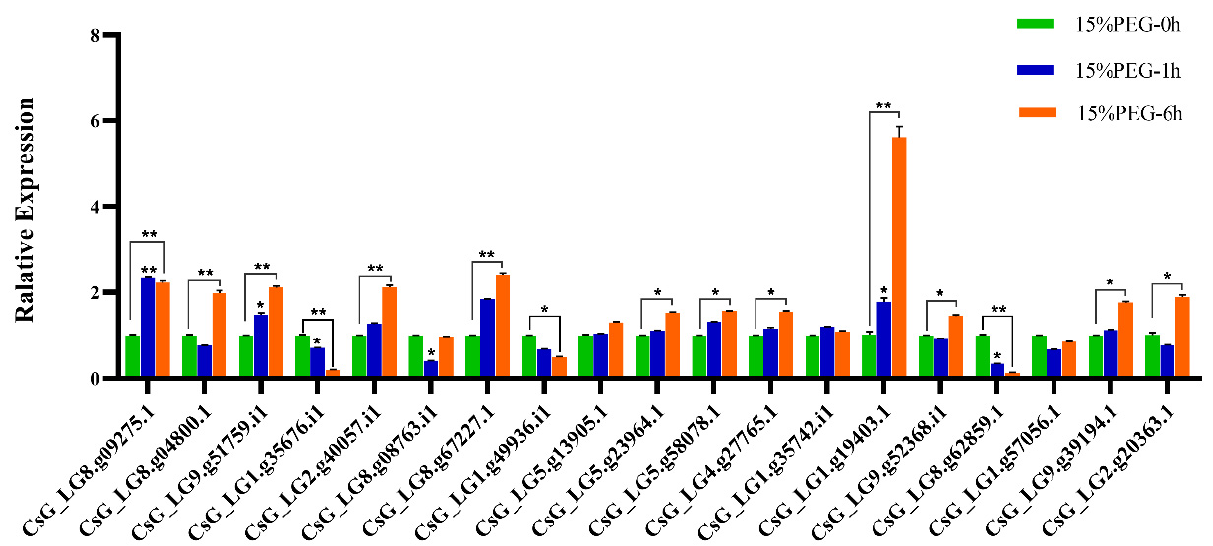
Figure 6. Expression patterns of CsNF-Y family genes in response to drought stress. The treatment concentrations were 15% PEG 6000. Values are mean ± S.D. * p ≤ 0.05, ** p ≤ 0.01, Sidak’s test.